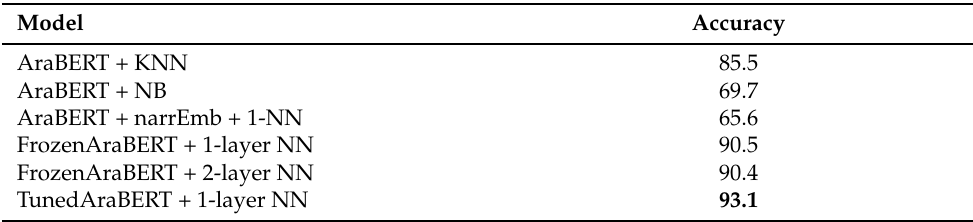
Table 4. Experiments on lite dataset using AraBERT.